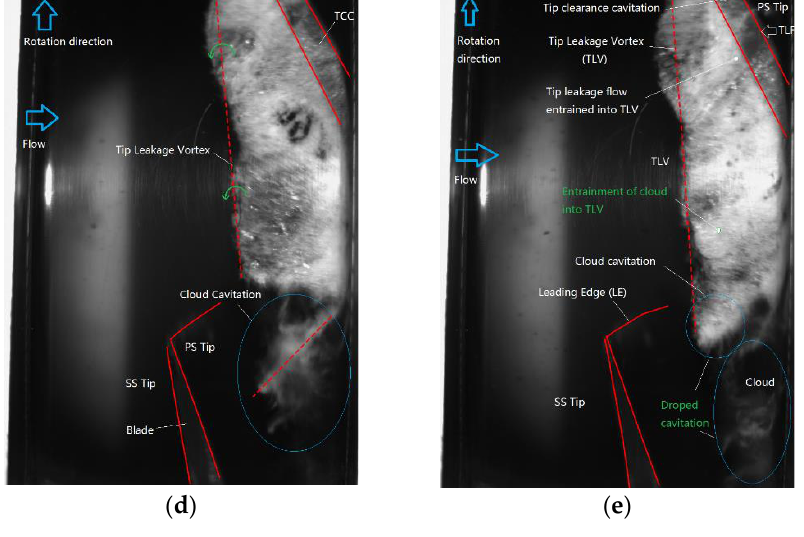
Figure 8. The cavitation flow structures at different cavitation developments [28]. ( a ) Point A, ( b ) point B, ( c ) point C, ( d ) point D, and ( e ) point E.